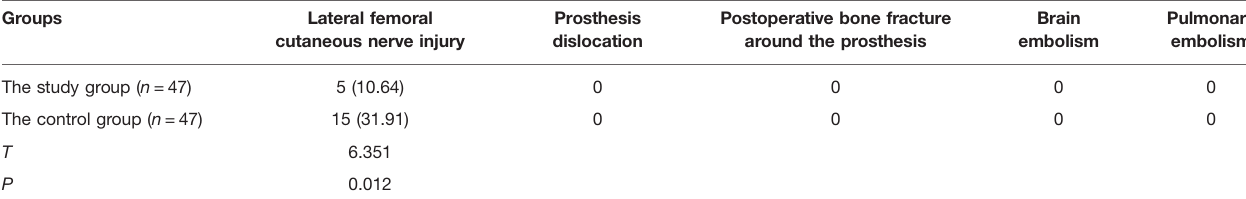
TABLE 6 | Comparison of the incidence of complications between the two groups, n